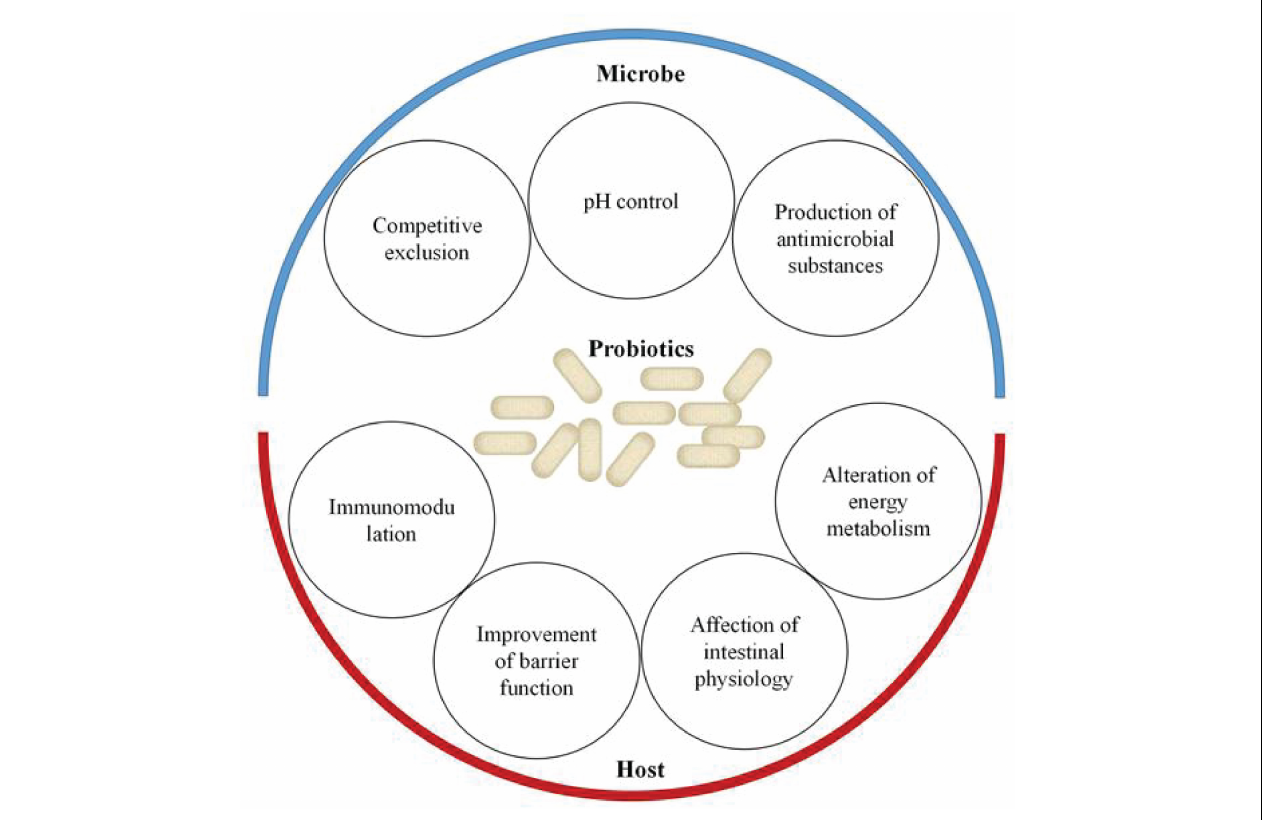
FIGURE 2 | Effects of probiotics on the host–microbe interactions. Probiotics support the stability of the bacterial community and restore the “signature” of gut microbiota through competitive exclusion, pH control, and production of antimicrobial substances. On the other hand, probiotics promote health benefits for the host through improvement of barrier function, immunomodulation, affection of intestinal physiology, and alteration of energy